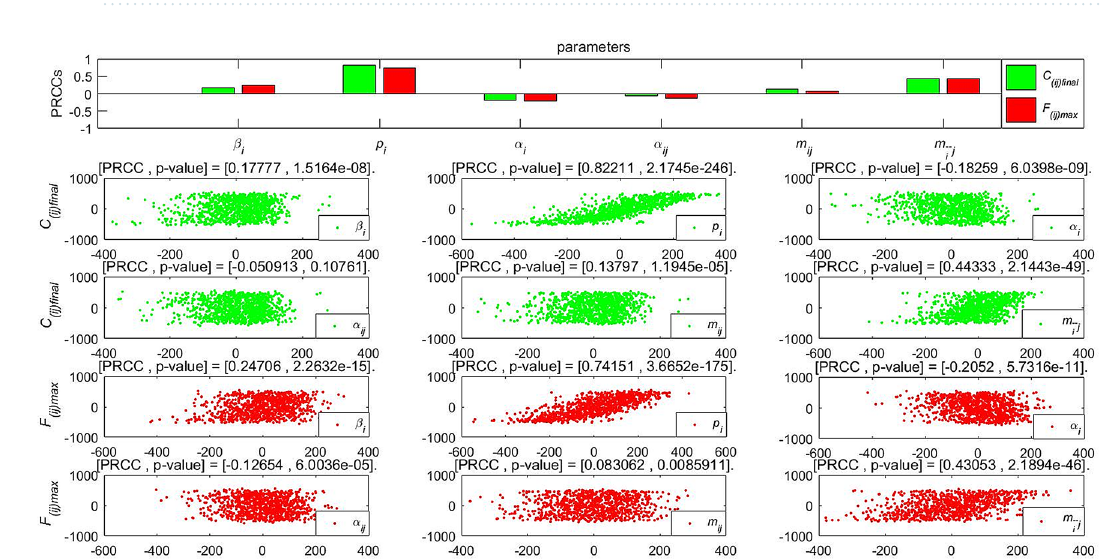
Figure 16. PRCC results and PRCC scatter plots with population C ( ij ) final and F ( ij ) max of different